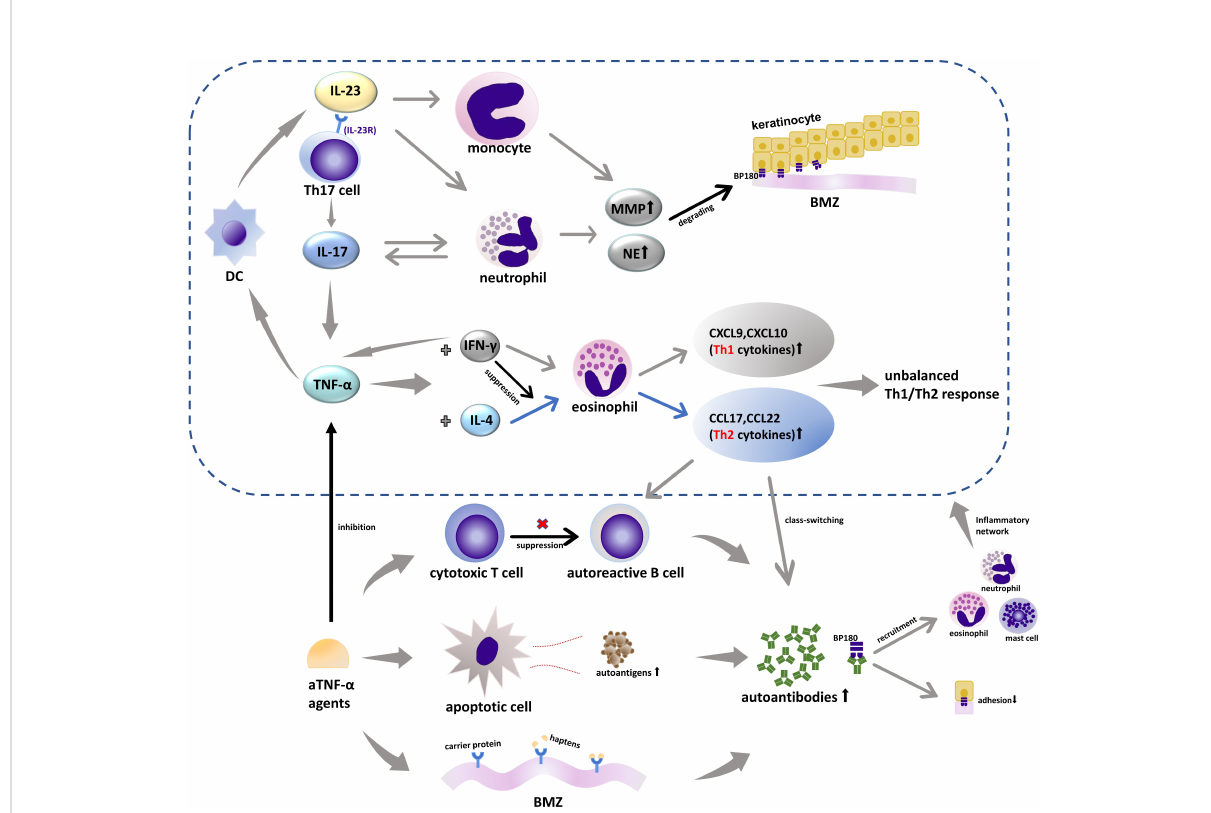
FIGURE 1 TNF- a -, IL-17-, and IL-23-associated in fl ammatory networks in BP and biologics. IL-23 acts as an upstream regulatory cytokine for the secretion of IL-17 from Th17 through IL-23R and can induce MMP-9 expression by monocytes alone. IL-17 can promote the production of a series of in fl ammatory molecules including TNF- a and increase the secretion of MMP-9 and NE from neutrophils that are involved in the formation of subepidermal blisters. TNF- a , which is considered as an upstream product of IL-23, can act on DCs that can secrete IL-23. TNF- a can also induce different immune responses dominated by Th1 or Th2 depending on the micro immune pro fi le (the levels of IL-4 and IFN- g ). IFN- g reduces the response of eosinophil to IL-4 plus TNF- a and can increase the production of endogenous TNF- a of different cell types in a speci fi c microenvironment. aTNF- a agents increase the production of autoantibodies in three ways: increasing cell apoptosis and espousing autoantigens, inhibiting the cytotoxic T-cell response that was involved in suppressing autoreactive B cells, and acting as antigenic haptens to bind or modify proteins in the BMZ. TNF- a , tumor necrosis factor a ; IL-17 , interleukin 17; IL-23 , interleukin 23; IL-23R , interleukin 23 receptor; MMP-9 , matrix metalloproteinase 9; NE , neutrophil elastase; DC , dendritic cell; IL-4 , interleukin 4; Th, helper T cells; IFN- g , interferon g ; BMZ , basement membrane zone; CCL , chemokine (C-C motif) ligand; CXCL , C-X-C motif